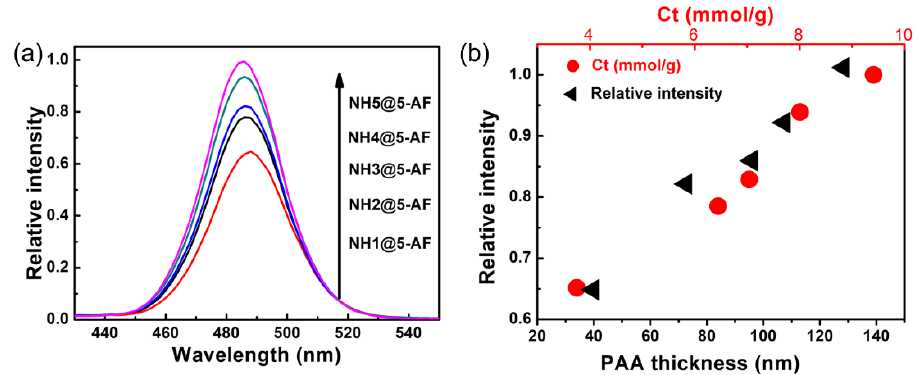
Figure 3. ( a ) DLS of HNs; ( b ) conductivity of HNs.